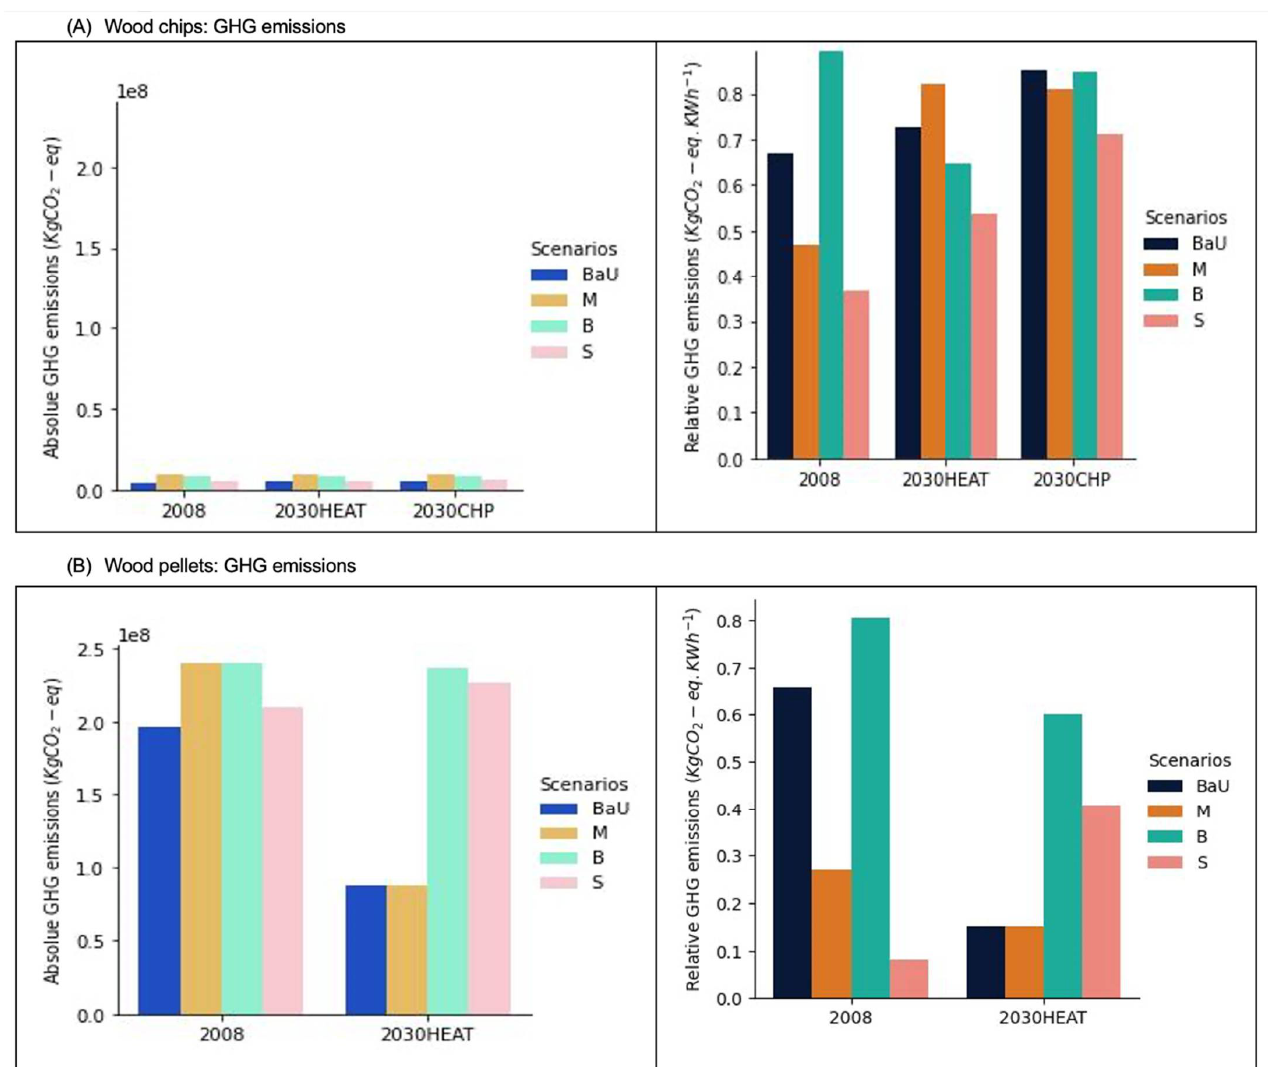
Figure 2. GHG emissions from fossil fuels generated during harvesting and transport for wood chip ( A ) and wood pellet ( B ) value chain scenarios. ( Left panel ): Absolute GHG emissions from harvesting and transport, expressed in kg of CO 2 equivalent. ( Right panel ): Relative GHG emissions from harvesting, transport, and combustion, expressed in kg of CO 2 equivalent emitted per kWh of energy produced.